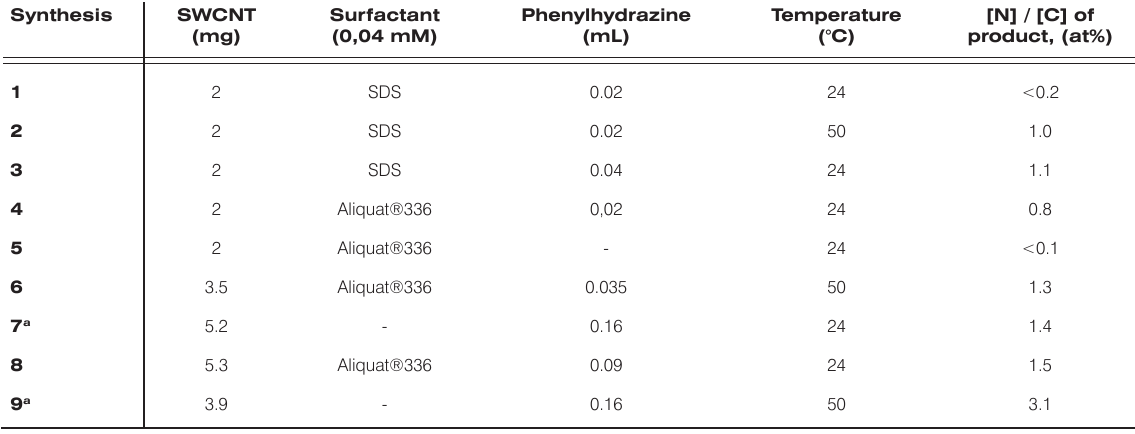
Table 1. Compendium of synthesis data.